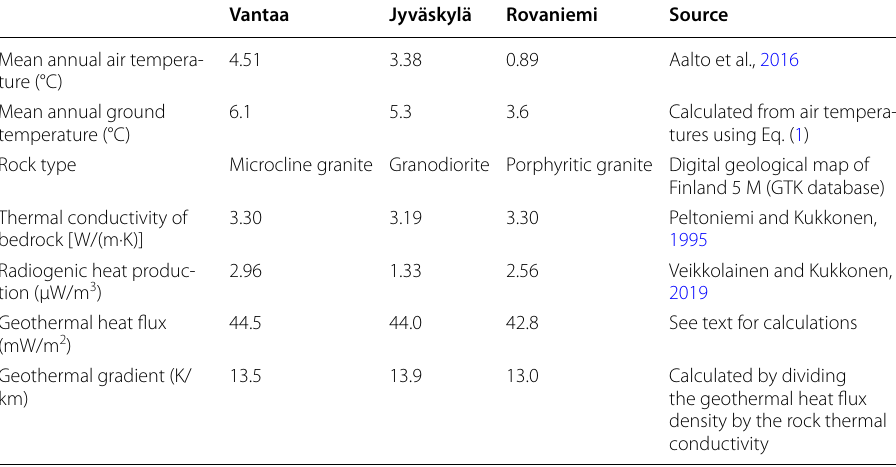
Vantaa Jyväskylä Rovaniemi Source 4.51